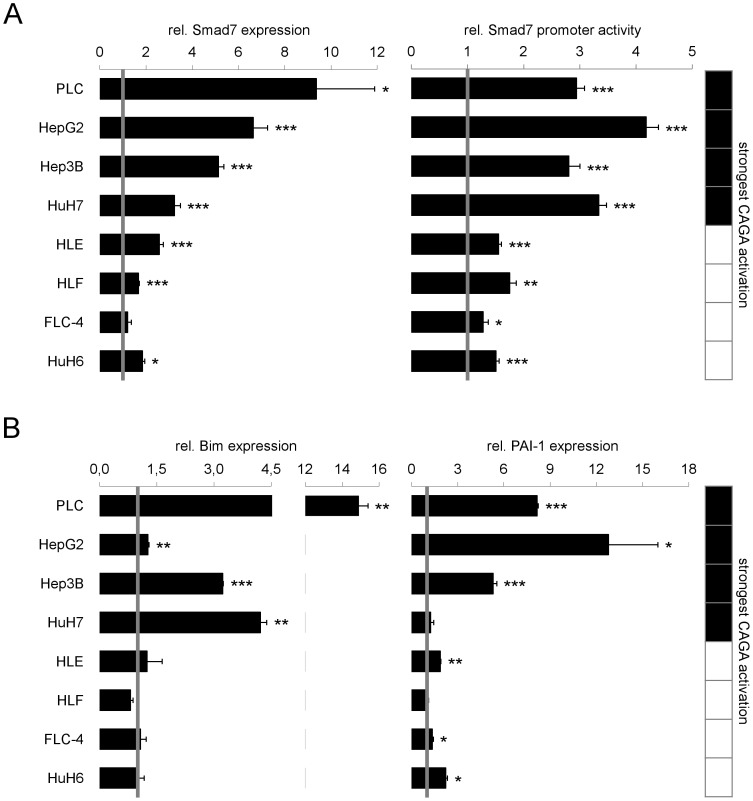
Induction of Smad7 expression by TGF-β correlates with cytostatic responsiveness.(A) Left side: Cells were treated with or without TGF-β for 2 h. Smad7 expression and 18S rRNA levels as reference gene were detected by real time PCR. Right side: For evaluation of transcriptional activity, HCC cell lines were transfected with a construct containing a luciferase gene under control of the Smad7-promotor and treated with TGF-β for 6 h. Treated samples were correlated to untreated controls. (B) Changes in expression levels of Smad3 target genes Bim and PAI-1 were detected after 2 h (PAI-1) or 24 h (Bim) using real time PCR analysis with rS18 as reference gene. The tables highlight cell lines with highest CAGA activity (black fields). Significant differences are indicated as * p < 0.05, ** p < 0.01 and *** p < 0.001 (Student’s t test).